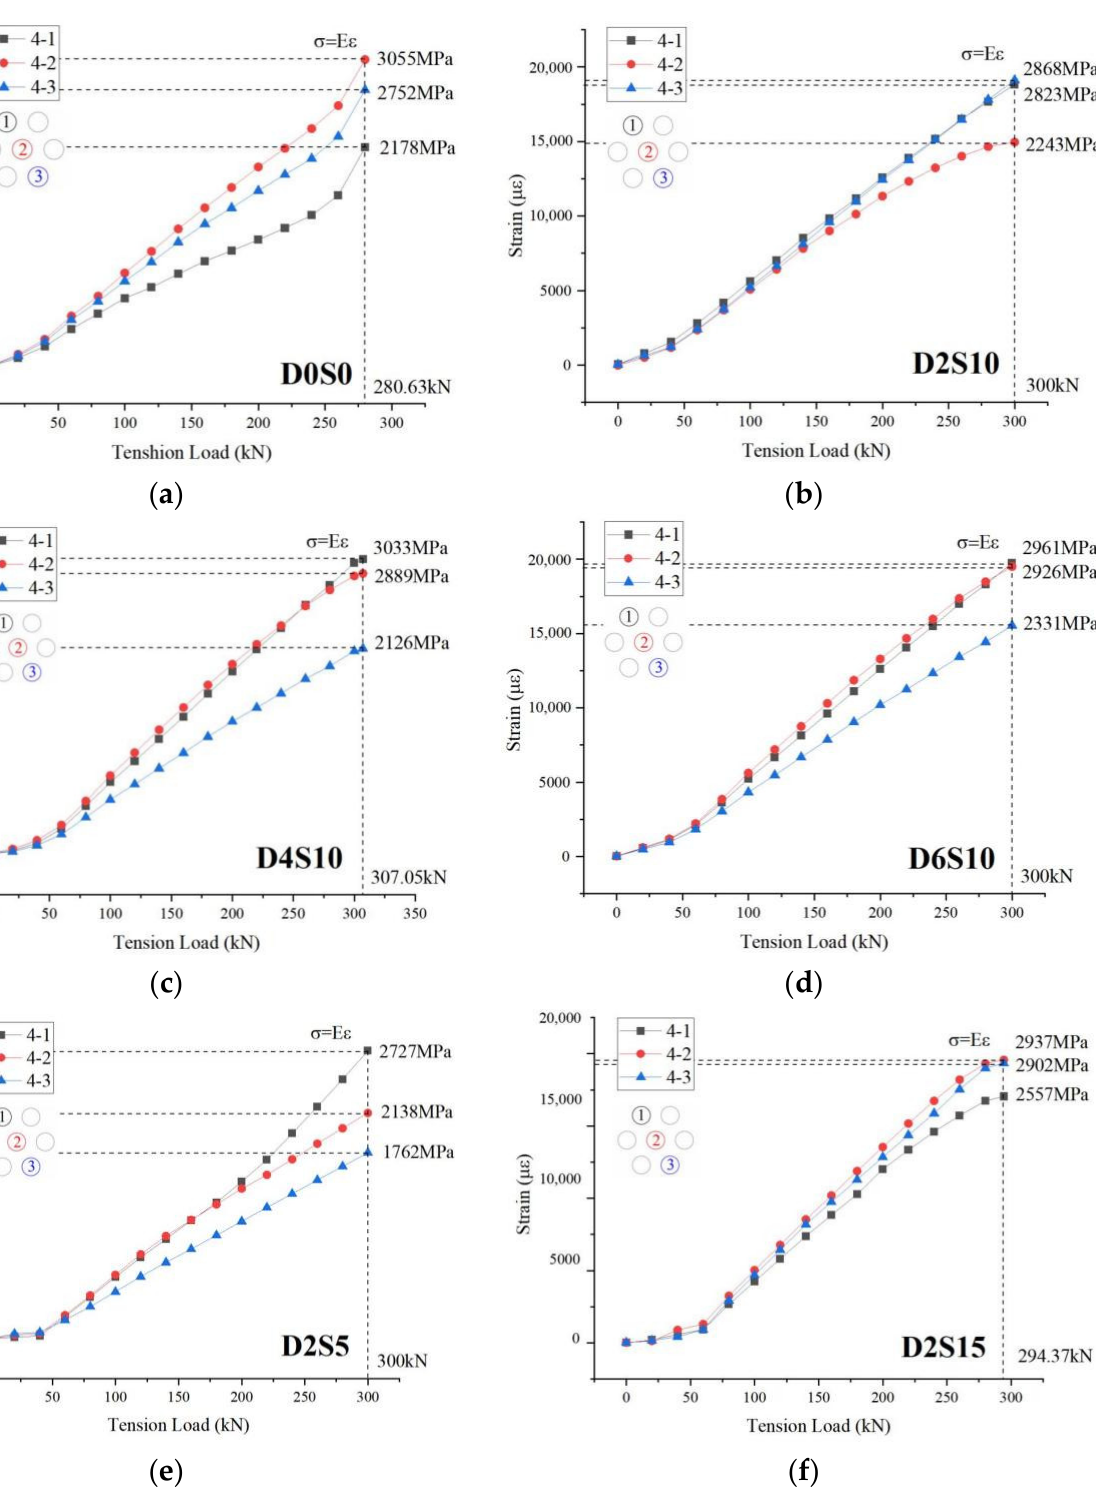
Figure 8. Load–strain curve of specimen: ( a ) D0S0; ( b ) D2S10; ( c ) D4S10; ( d ) D6S10; ( e ) D2S5; ( f ) D2S15.